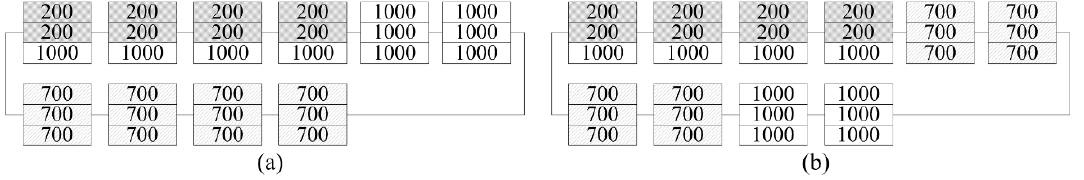
Figure 11. ( a ) Optimized configuration C EMPP and ( b ) optimized configuration C opt .